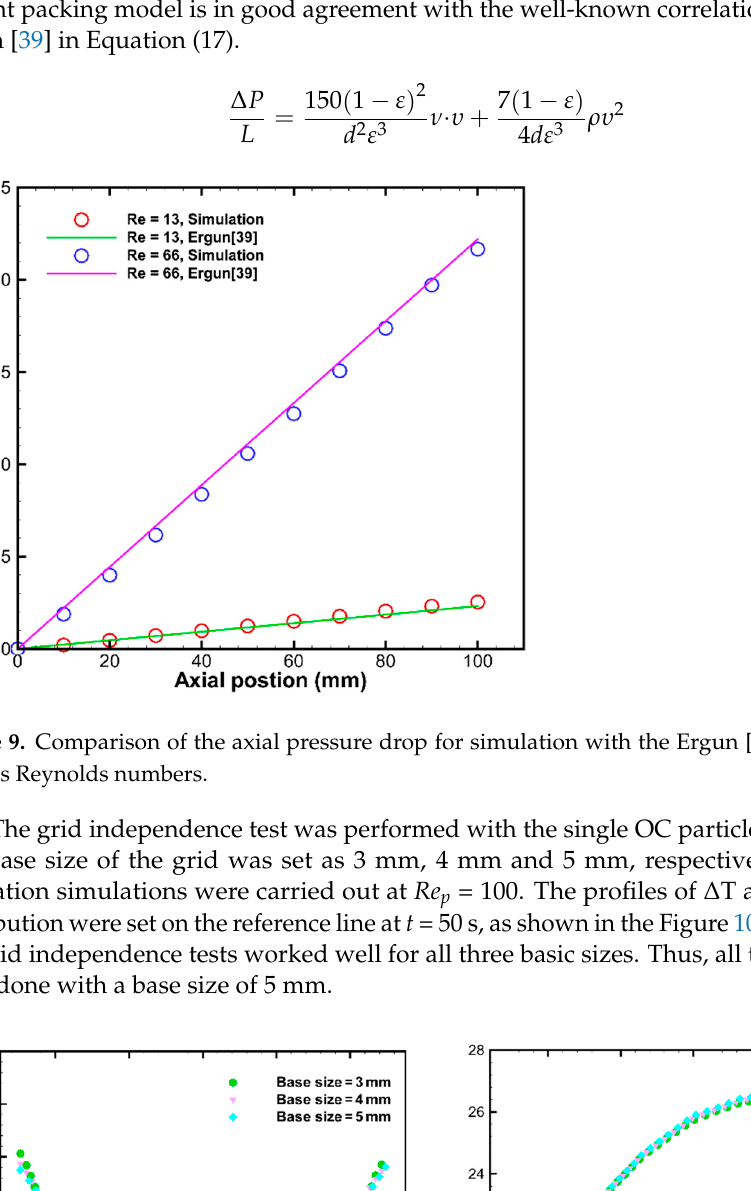
Figure 8. Comparison of radial porosity distribution profile for the current packing model with a correction from de Klerk [37] and an algorithm from Mueller [38].